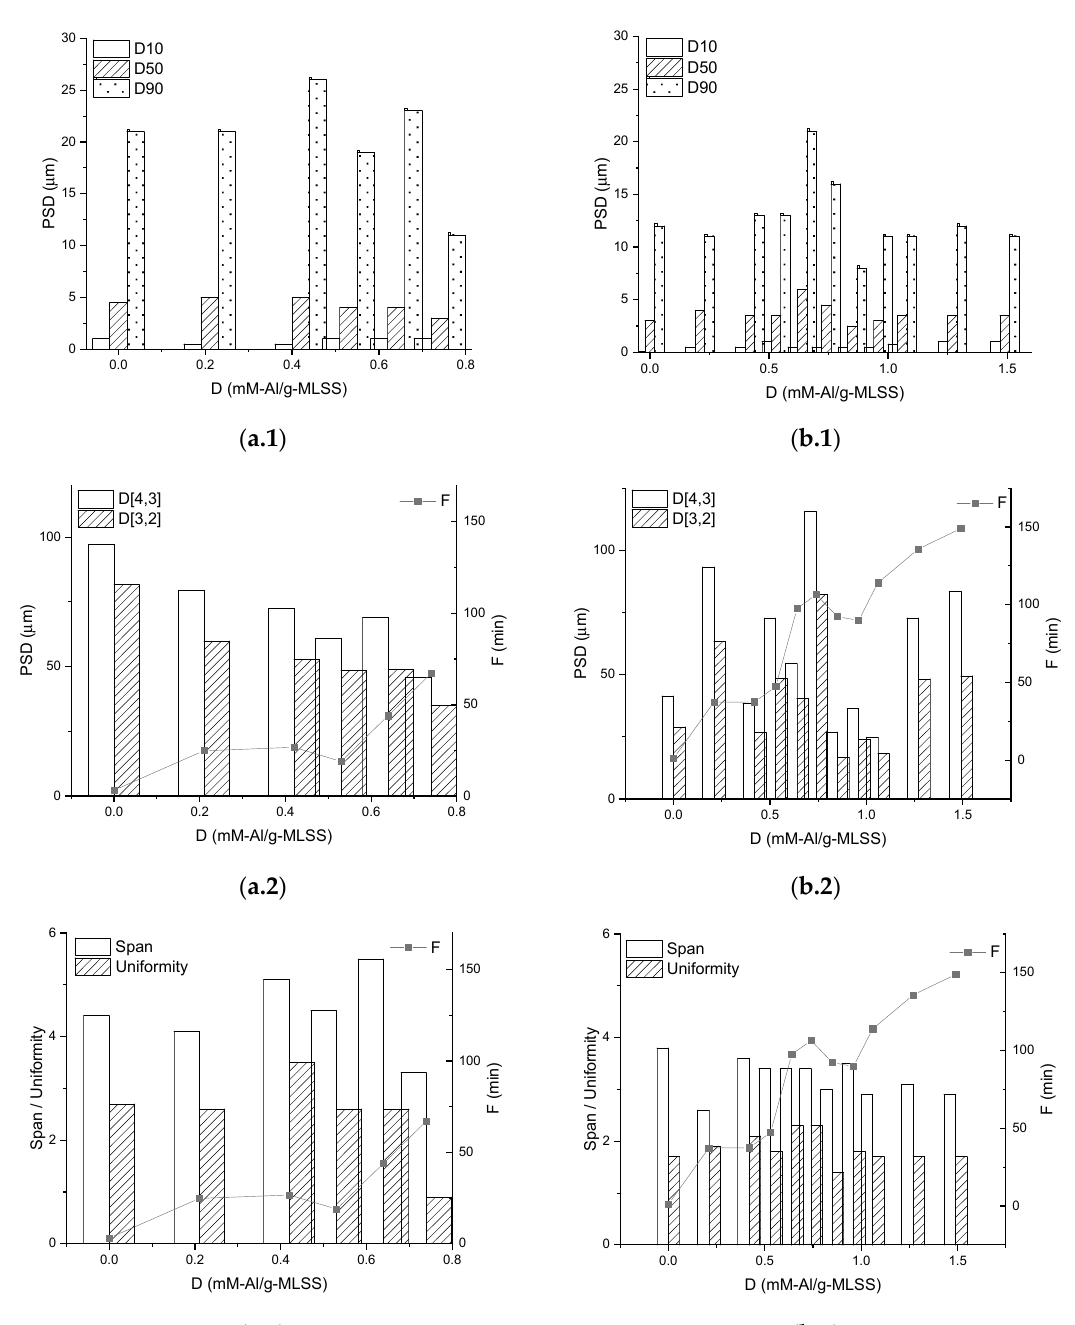
Figure 9. Particle Size Distribution in sediments after Total Recycle Tests with Mixed Liquors from MBBR ( a ) and IFAS ( b ) at different doses of the chemical enhancer, expressed as distribution points ( 1 ), means ( 2 ), span and uniformity ( 3 ).